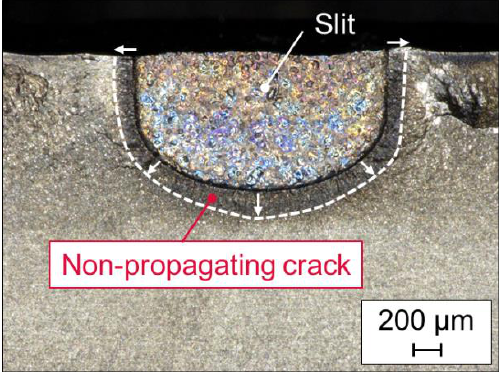
Figure 14. Fracture surface around the slit for WNS1.0 tested under the fatigue limit of σ w = 240 MPa. Non-propagating cracks were marked with a heat tint color via heat treatment at 573 K in air. The specimen was compulsorily fractured in a brittle manner using liquid nitrogen after a fatigue crack propagated under excessive cyclic